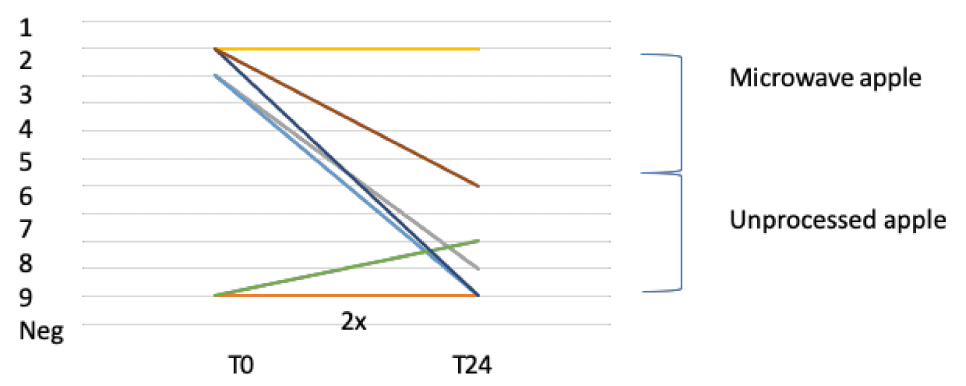
Figure 4. Challenge results of eliciting-dose reaction to open apple before and after 24 months of BP-AIT. Neg. (2 × ): In two patients the OFCs with unprocessed apple were negative at T0 and T24. Table 3. Challenge results of the eliciting-dose from double-blind, placebo-controlled challenge (DBPCC) with rMal d 1 over time. DBPCC With rMal d 1